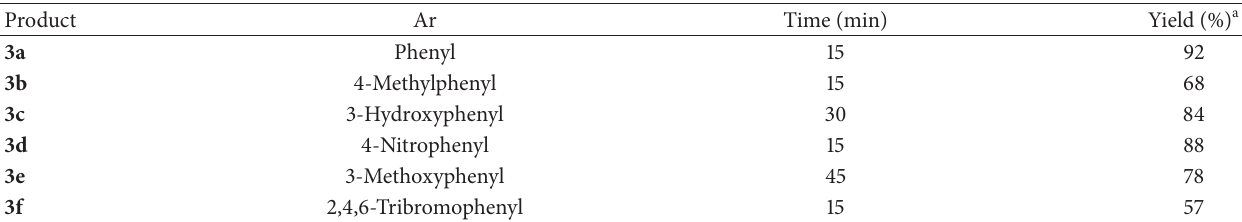
Table 1: Synthesis of functional aryl vinyl ethers 3a–f